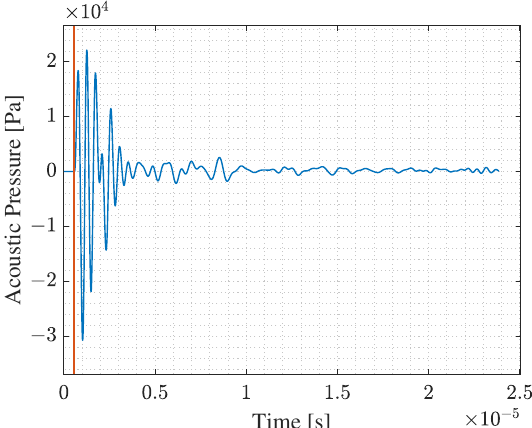
Figure 12. Computed acoustic pressure history at bolt head/silicone layer interface.